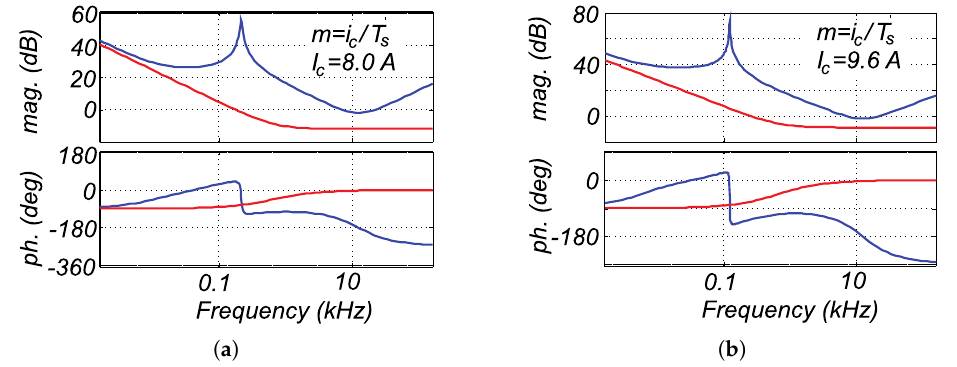
Figure 13. Frequency response, current control with PI compensator, G id ( s ) F ( s ) F hf ( s ) ( 1 + C i ( s )) (blue curve) and C i ( s ) (red curve), for ( a ) buck controller design; ( b ) boost controller design.